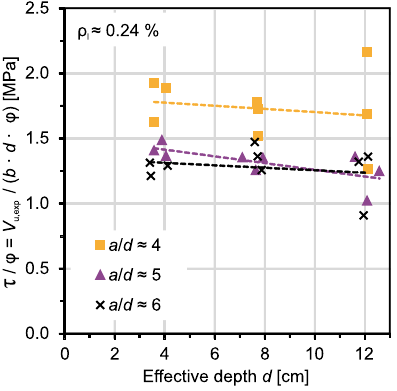
Figure 8. Relative shear stress considering the size effect factor according to Bazant [81] with λ 0 = 25 and d a = 4 mm.